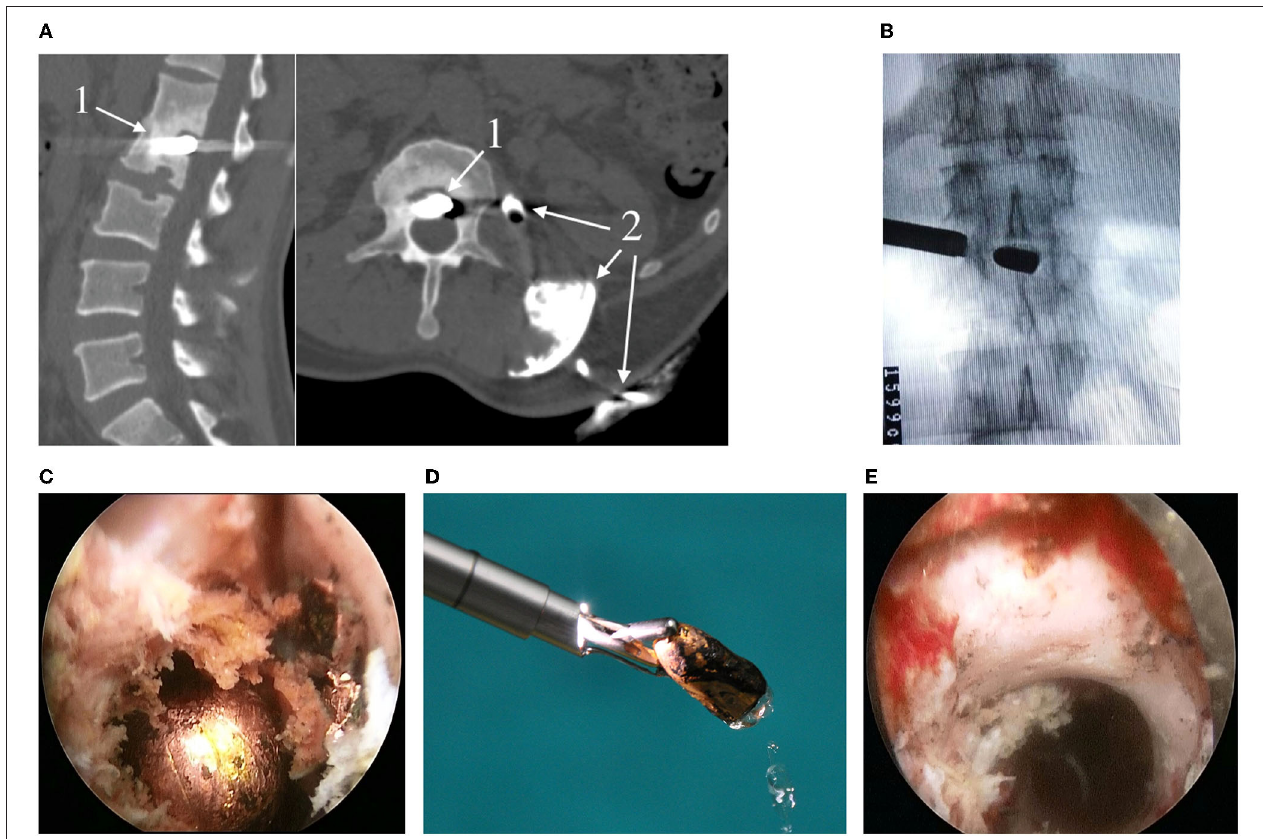
FIGURE 2 | (A) Preoperative sagittal CT (left) and CT fistulography (right) of the lumbar spine: 1—bullet; 2—contrast agent; (B) Radiography of the working port and bullet; (C) Endoscopic stage of the surgery and view of the bullet (described in the text); (D) Capturing and extracting the bullet with forceps (caliber 7.62mm, length 15mm); (E) Endoscopic view of the intervertebral foramen after extracting the bullet.